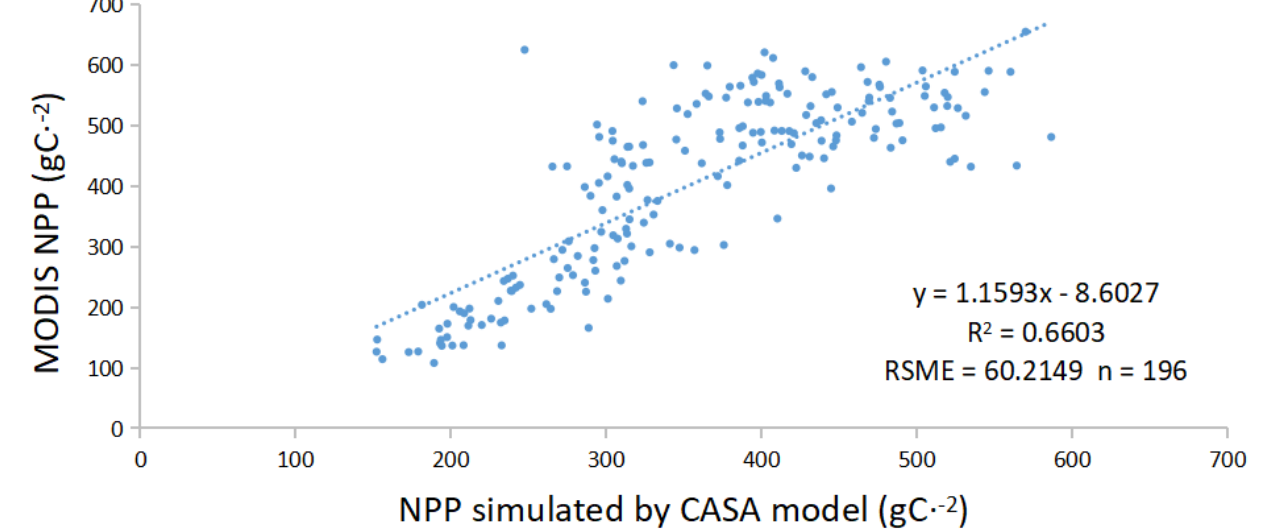
Figure A1. Comparison of NPP obtained from the CASA model and MODIS products in 2000.